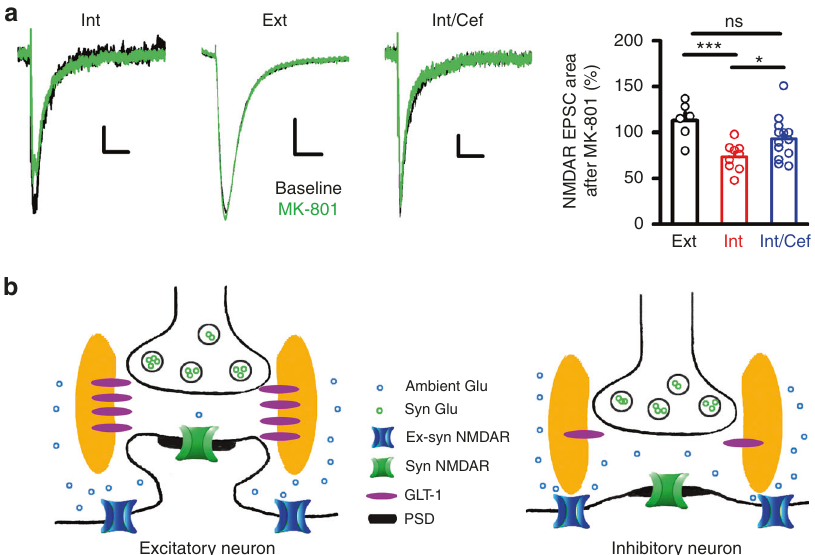
Fig. 7 Differential impact of ambient glutamate on synaptic NMDAR responses in excitatory and inhibitory neurons. a Ambient glutamate activation of synaptic NMDARs was assayed by measuring the use-dependent blockade by MK-801 in the absence of synaptic stimulation (see text). Synaptic NMDAR EPSCs were reduced by MK-801 application in the absence of synaptic stimulation in inhibitory neurons but not excitatory neurons and this reduction was ameliorated in inhibitory neurons from Cef-treated mice. Sample traces of NMDAR EPSCs before and after MK-801 application in an inhibitory neuron (left), an excitatory neuron (middle), or an inhibitory neuron from a Cef-treated mouse (right). Scale bars, 10 pA/100ms (left); 30 pA/100ms (middle); 10 pA/100 ms (right). No signi fi cant change in NMDAR EPSCs area was observed after MK-801 in excitatory neurons ( N = 6), while a signi fi cant reduction was observed in inhibitory neurons ( N = 9; *** P < 0.001, 113.1 ± 8.25% (Ext), 73.67 ± 4.97% (Int), unpaired t test, compared to excitatory neurons). Inhibitory neurons in Cef-treated mice showed a signi fi cantly reduced effect of MK-801 application ( N = 13; 73.67 ± 4.97% (Int), 93.44 ± 6.52% (Ext). * P < 0.05, unpaired t test, compared to inhibitory neurons without Cef injection). b A model depicting the differential resting glutamate levels in the synaptic cleft in excitatory (left) and inhibitory (right) neurons, likely caused by difference in the density/activity of glutamate transporters (such as GLT-1s). Error bars represent SEM. ns not signi fi